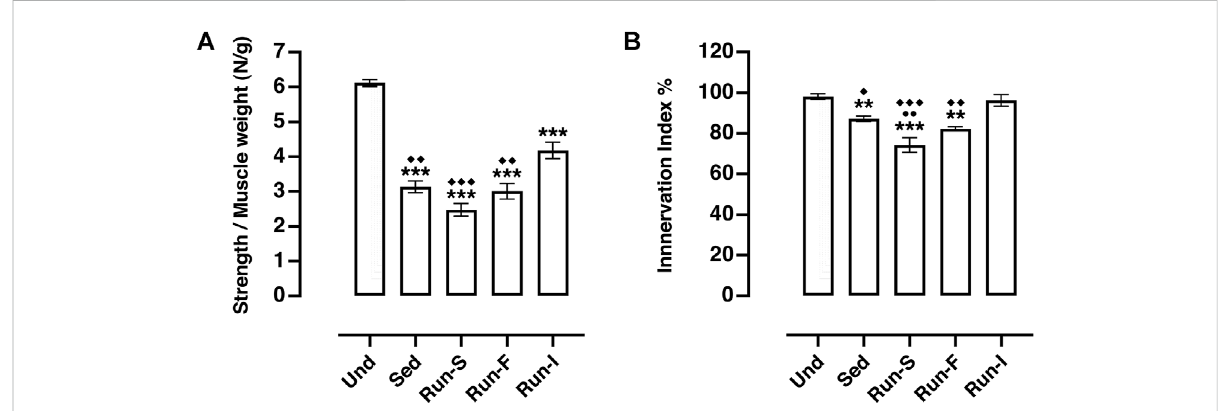
FIGURE 3 Effect of different exercise protocols on soleus muscle re-innervation 10 days after nerve crush. (A) In vivo muscle tension recordings obtained by the tetanic stimulation of nerve. One-way ANOVA: F (4, 23) = 48.27, p < 0.001; Tukey ’ s post hoc test: *** p < 0.001 vs. Und, ◆◆ p < 0.01 and ◆◆◆ p < 0.001vs.Run-I(Und n =5,Sed n =9,Run-S n =4,Run-F n =4andRun-I n =6). (B) Muscleinnervationindexcomputedasstrengthobtainedbynerve stimulation/strength obtained by muscle stimulation (both normalized to muscle weight) ratio. One-way ANOVA: F (4, 22) = 18.05, p < 0.001; Tukey ’ s post hoc test: ** p < 0.01 and *** p < 0.001 vs. Und; CC p < 0.01 vs. Sed; ◆ p < 0.05, ◆◆ p < 0.01 and ◆◆◆ p < 0.001 vs.Run-I (Und n =5, Sed n= 8, Run-S n = 4, Run-F n = 4 and Run-I n = 6). Data are expressed as mean and